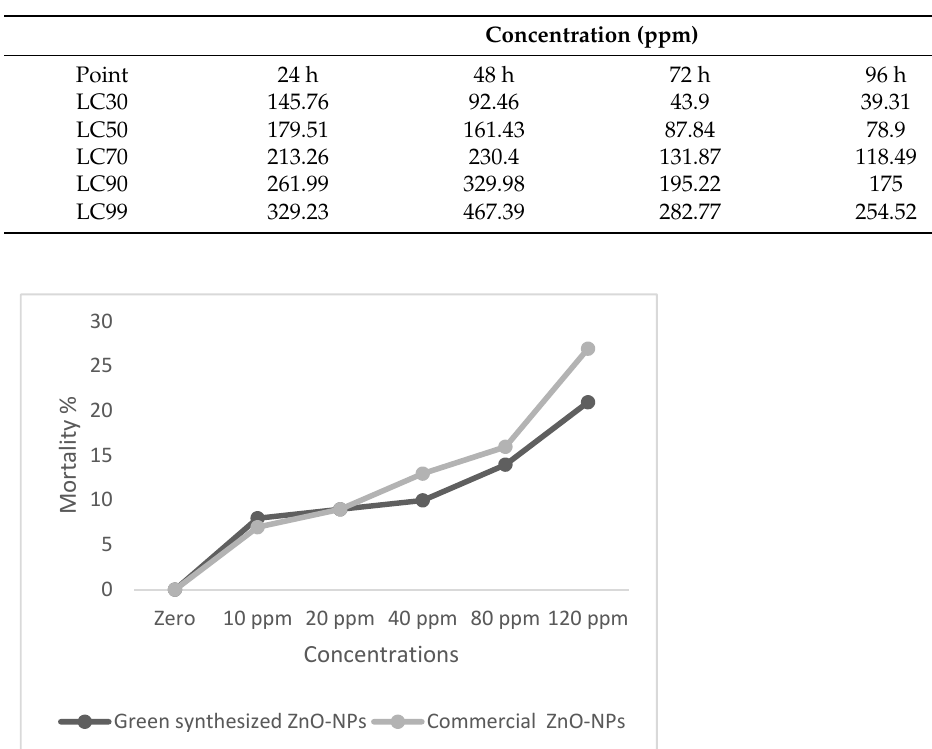
Figure 6. The cumulative mortality of common carp exposed to different levels of commercial and green synthesized ZnO-NPs for 96 h (30 fish for each concentration). Table 1. Lethal concentrations of commercial ZnO-NPs at different time points of 24, 48, 72, and 96 hrs.